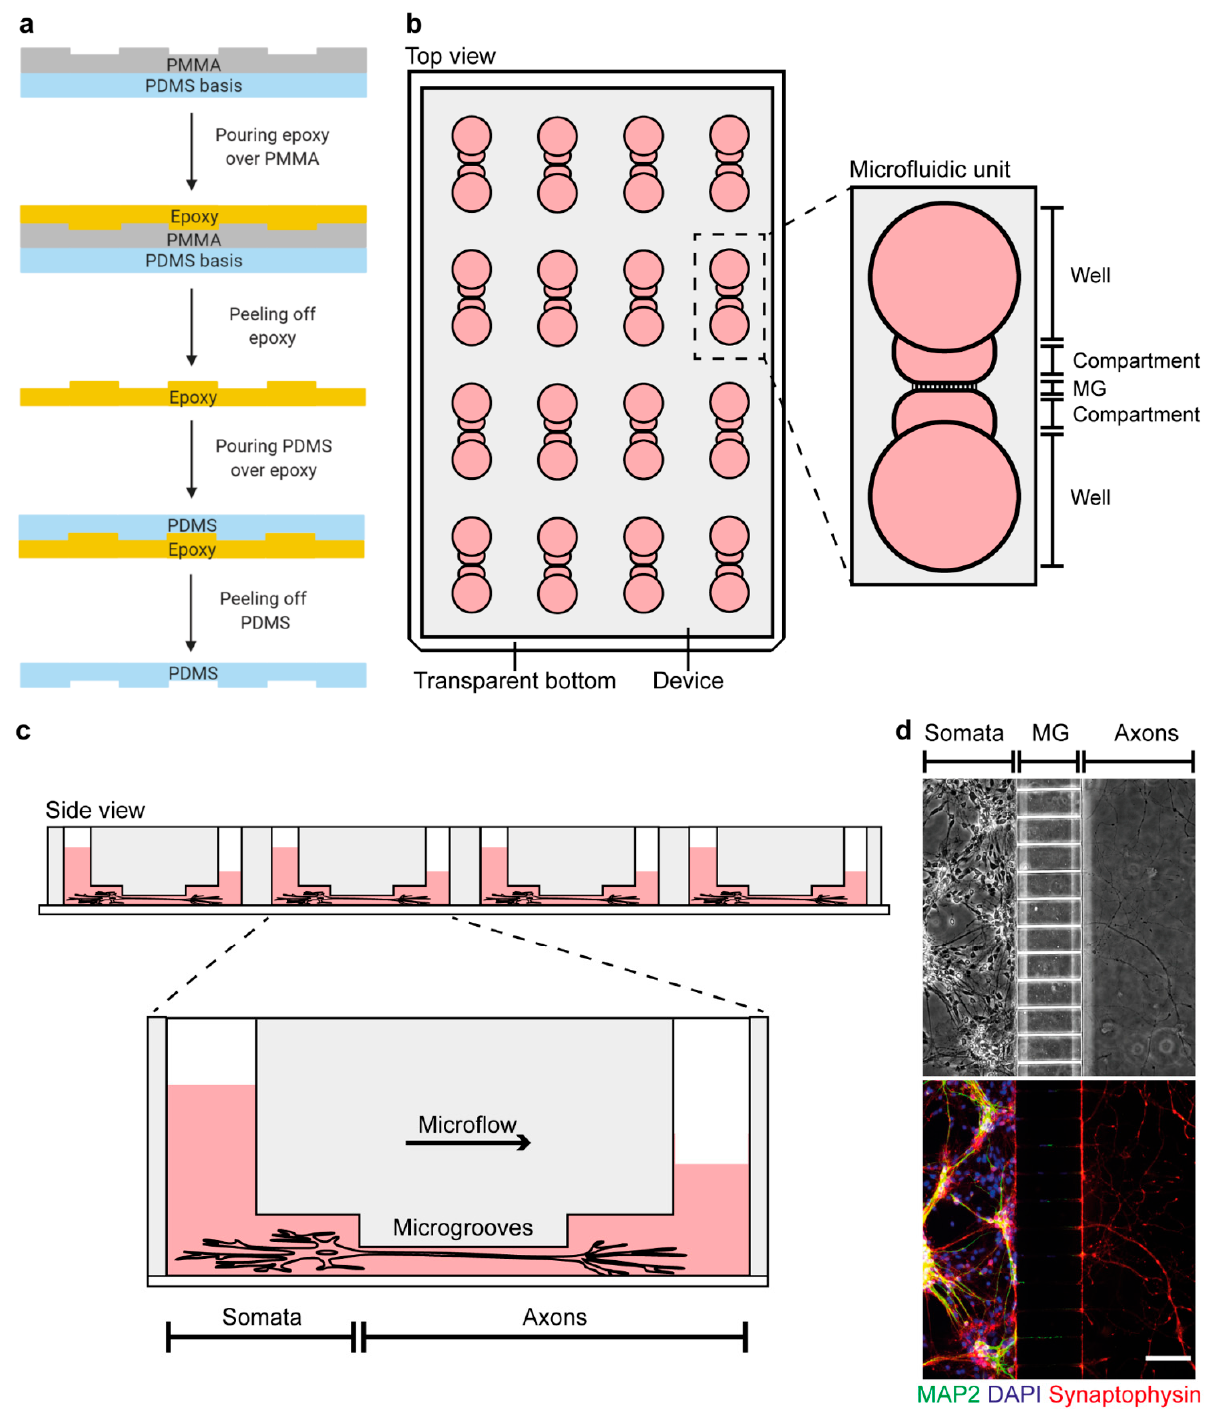
Figure 1. Microfluidic device for the enhanced throughput cultivation of axons. ( a ) Manufacturing process of the microfluidic device prototype created with BioRender.com. ( b ) The microfluidic device incorporates 16 individual microfluidic units for axon cultivation. One microfluidic unit consists of two wells that are connected through compartments and microgrooves (MG). ( c ) Primary cortical neurons are seeded into the soma compartment from which their axons grow through the MG into the axon compartment. Directed growth is supported by culture medium microflux due to different medium volumes between the two wells. ( d ) Phase-contrast image of primary cortical axons that were spatially separated from their somata by the MG at day in vitro 7, which we confirmed by immunofluorescence staining of dendrites using microtubule-associated protein 2 (MAP2, green, 1:4000) and axons using synaptophysin (red, 1:250). DAPI (blue, 1:1000) was used for nuclear counterstaining (top). Scale bar: 100 µm.